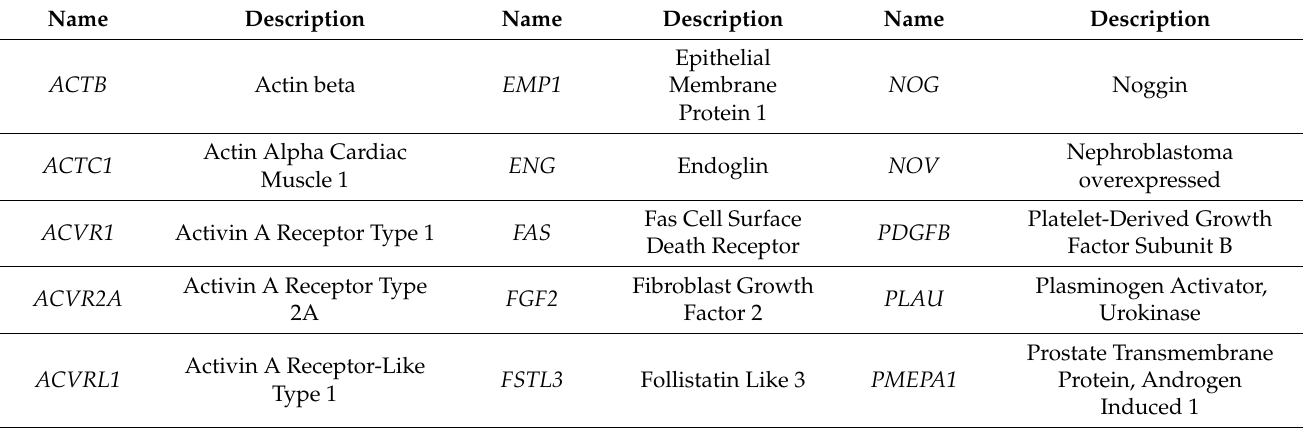
Table 2. List of genes tested in PrimePCR™ TGF β BMP Signalling Pathway Plus H96, 90 genes, Bio-Rad,